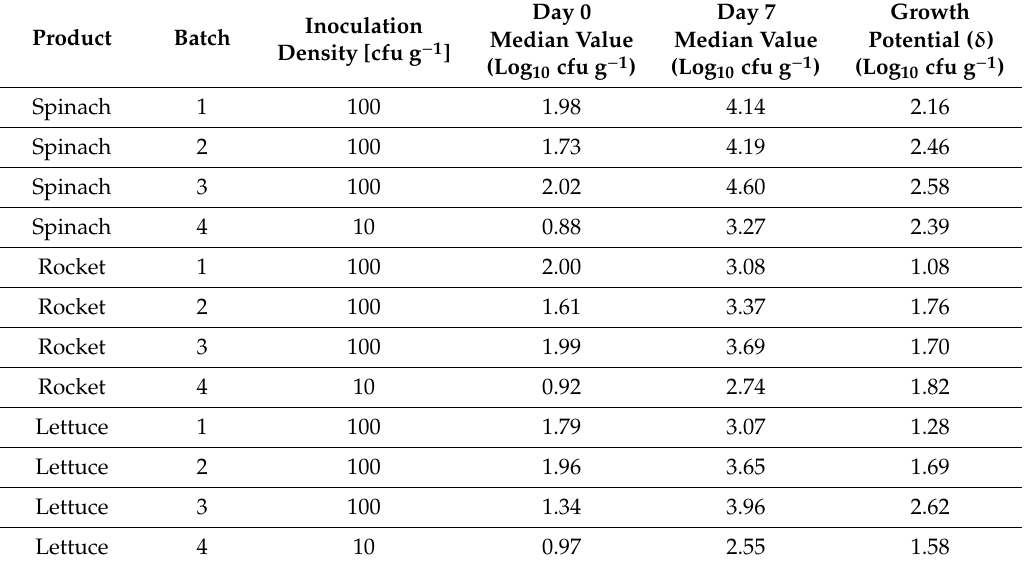
Table 1. Growth potentials (based on median values of results from day 0 and day 7) of L.